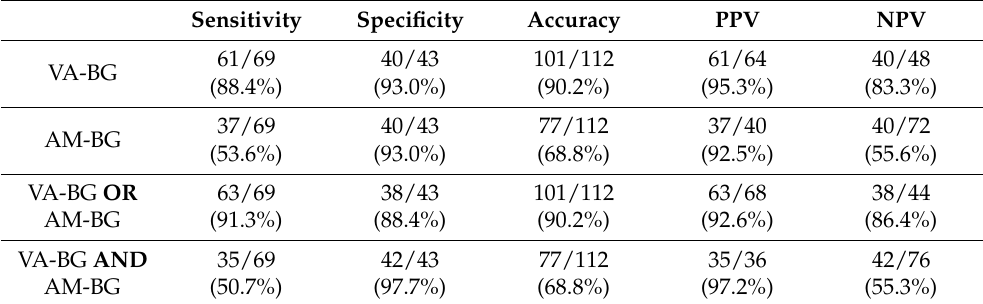
Table 2. Diagnostic performance parameters provided by visual assessment and automated method- based assessment of 18 F-DOPA uptake in the basal ganglia.